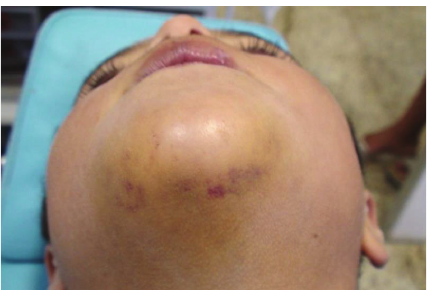
Figure 1: Extraoral view showing contusion lesion and abrasion on the chin.